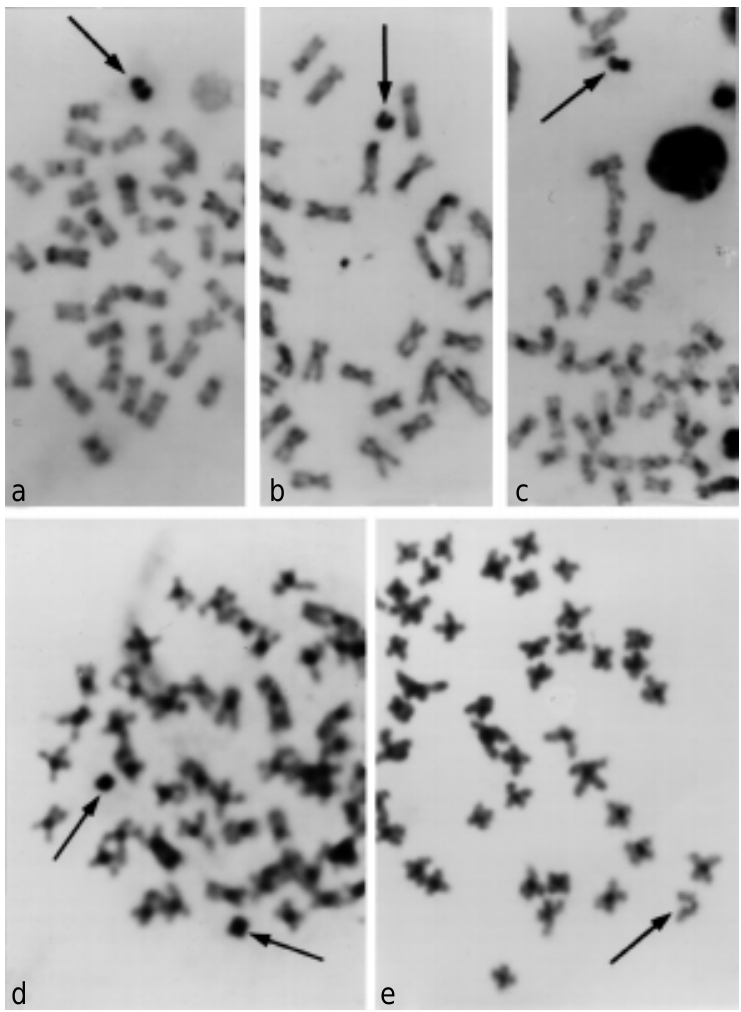
Figure 2 - C-banded partial metaphases of (a) Leporinus friderici from the Araguaia River, (b) Leporinus sp., (c) Cyphocharax modesta , (d) Prochilodus nigricans and (e) Characidium cf. zebra . The arrows indicate the supernumerary chromosomes.